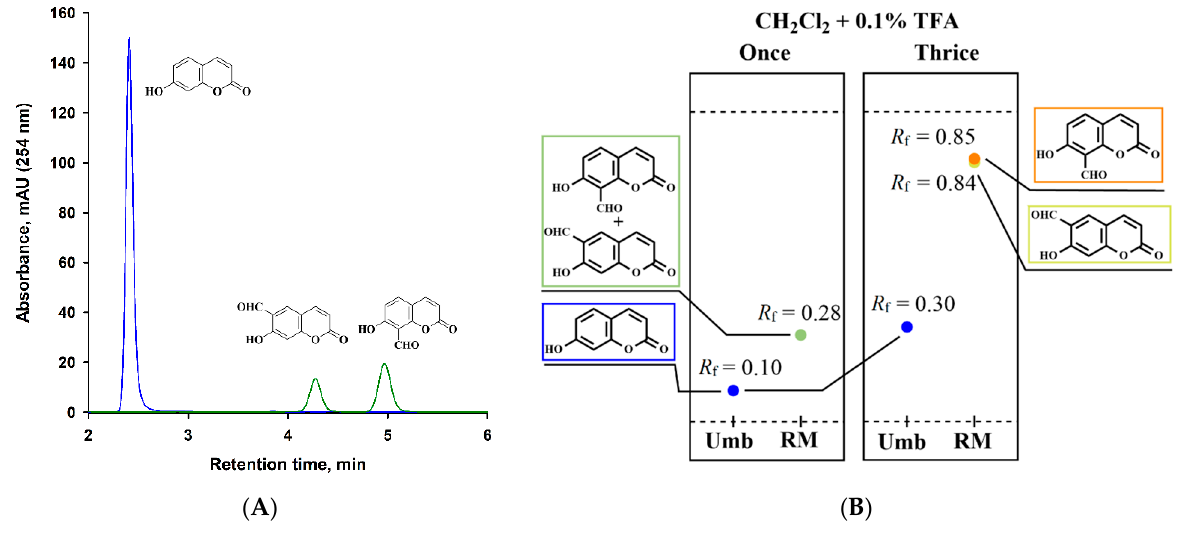
Figure 1. Detection of ortho -formylated umbelliferones as the products of the Duff reaction: ( A ) HPLC chromatogram of the reaction mixture before (blue) and after (green) 30 min reaction under the chosen reaction conditions. Conditions: column: Agilent Zorbax ® Eclipse XDB C18 Solvent Saver Plus (3.5 μ m; 3.0 × 75 mm); mobile phases: (A) water + 0.01% TFA, (B) acetonitrile + 0.01% TFA; gradient: 80% A and 20% B for 10 min; flow rate: 0.6 mL min − 1 ; temperature: 30 °C; injection volume: 20 μ L; DAD detection: 254 nm; ( B ) Schematized representation of TLC analysis of the starting Umb and the reaction mixture (RM) after reacting for 30 min. Conditions: TLC Plates: Merck "TLC Silica gel 60 ″ ; single ( left panel ) or triple ( right panel ) elution with CH 2 Cl 2 + 0.1% TFA; visualization: 365 nm.